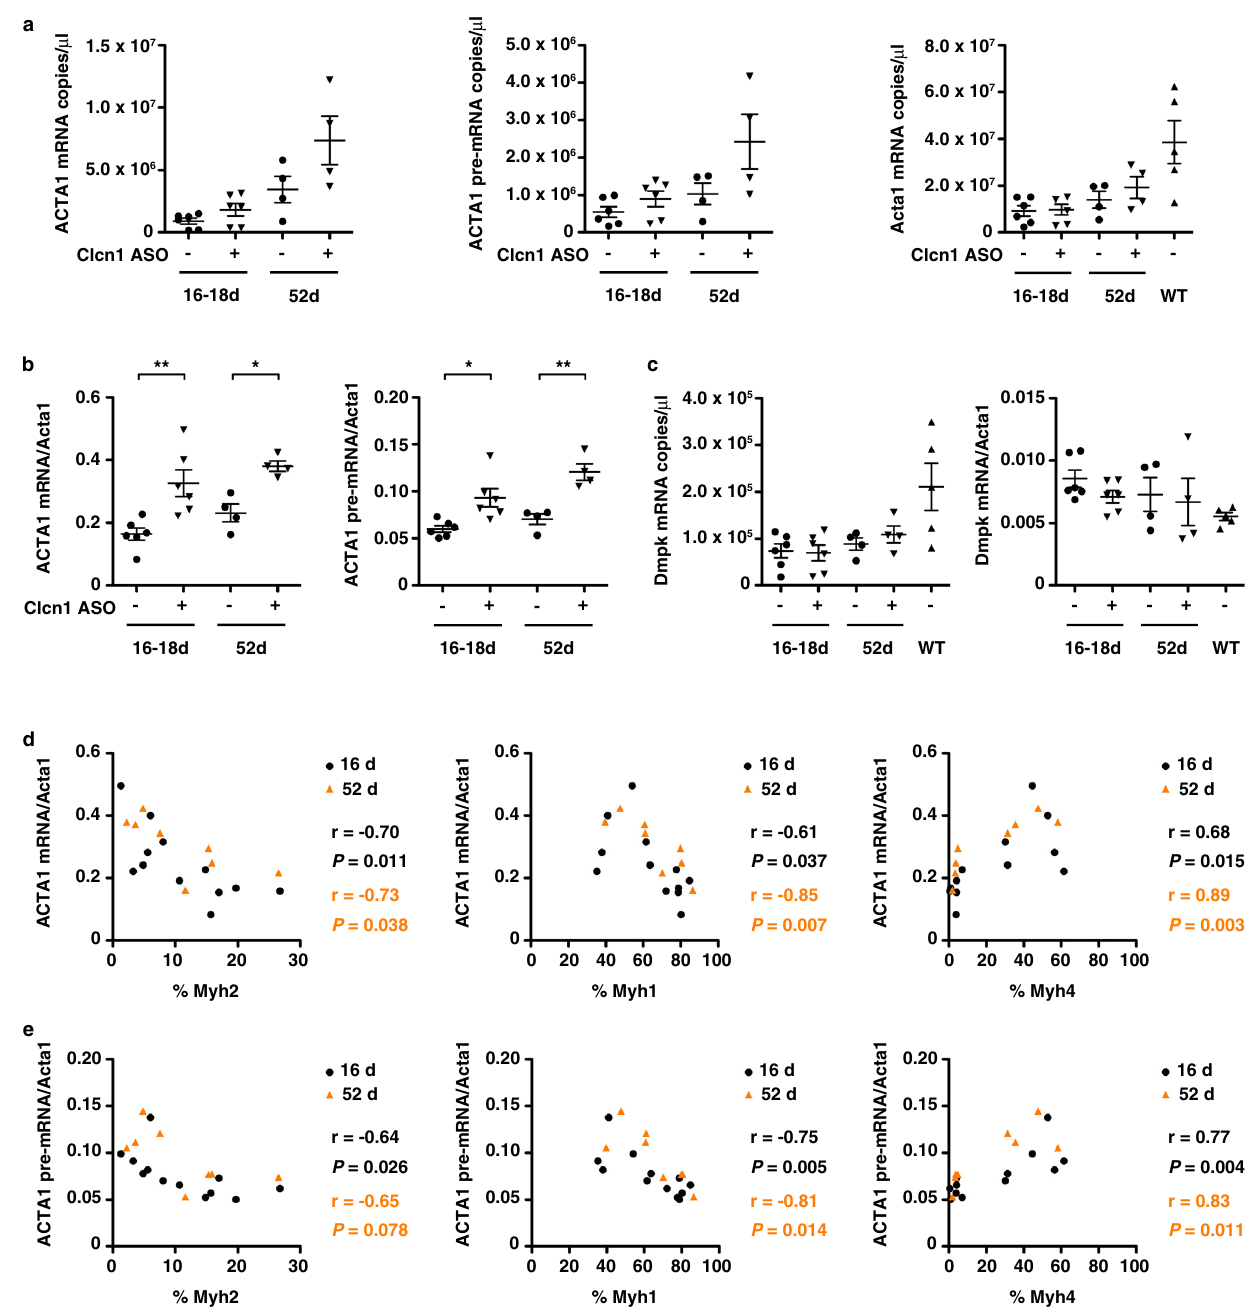
Fig.8|Relationshipof ACTA1 -CUG exp transgeneandmyosingeneexpressionin treatedmuscles.a WeusedddPCRtoquantifyexpressionofhuman ACTA1 -CUG exp mRNA, human ACTA1 -CUG exp pre-mRNA, and reference gene mouse Acta1 in TA muscles of LR41; Mbnl1 − / − ( N =10) treated with Clcn1 ASO (+) or invert oligo ( − ) as copies/ µ lcDNA.UntreatedWTTAmuscles( − )( N =4)servedascontrols. b Usingthe copies/ µ l cDNA data in a ), we normalized expression of ACTA1 -CUG exp mRNA (left) and ACTA1 -CUG exp pre-mRNA (right) to mouse Acta1 in LR41; Mbnl1 − / − ( N =10). ** P <0.01; * P <0.05 (one-way ANOVA). c ddPCRquanti fi cation of Dmpk expression